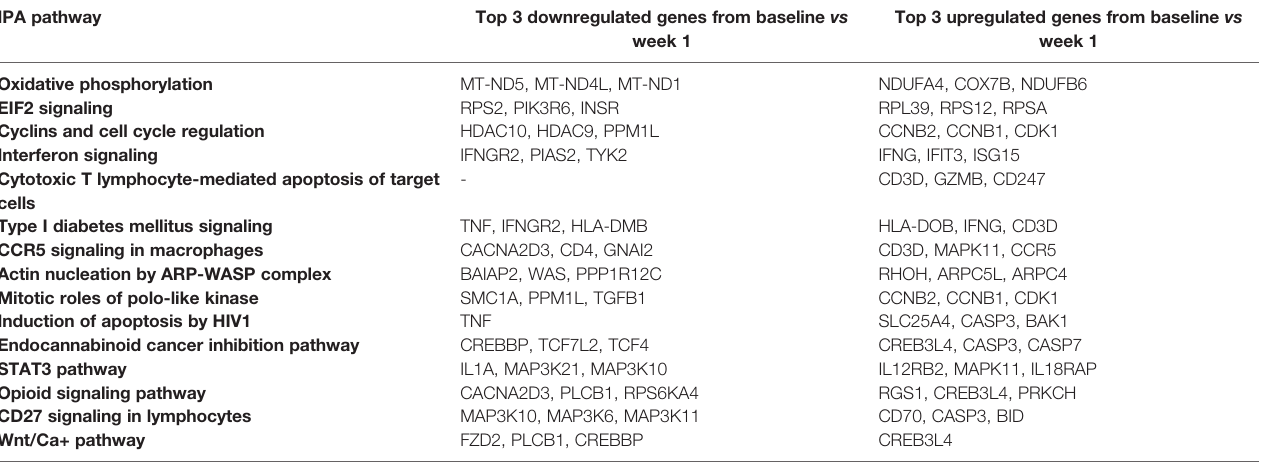
TABLE 3 | Top 3 up/downregulated genes from baseline vs week 1 enriching for IPA pathways. IPA pathway Top 3 downregulated genes from baseline vs